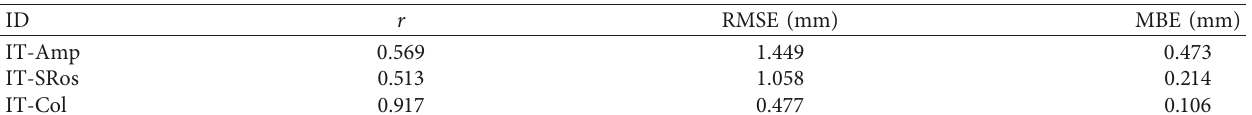
Table 4: Accuracy statistics of the ET A estimates obtained by the classical soil water balance method in the three study sites (all correlations are highly significant, P < 0 .